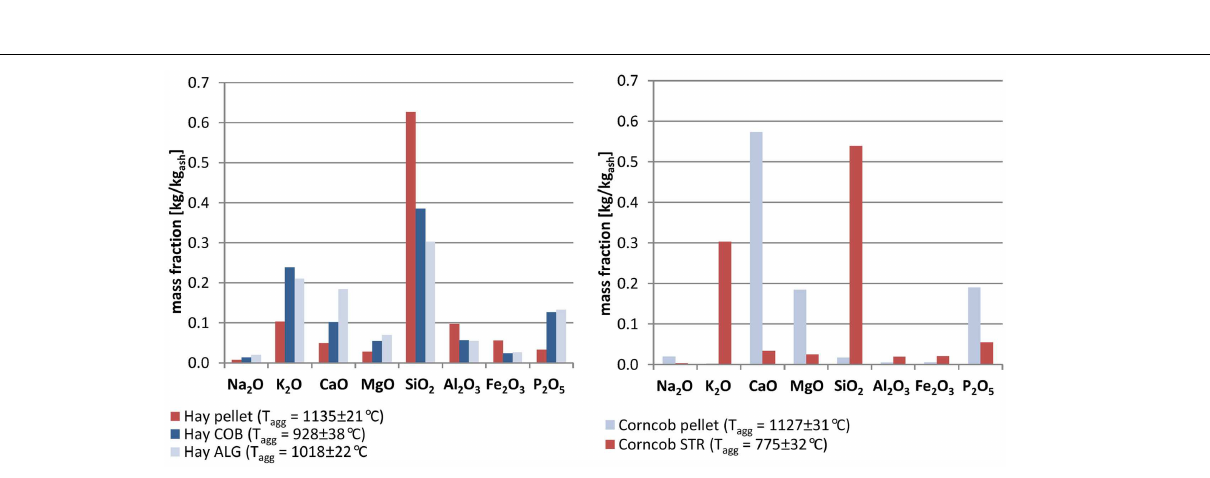
FIGURE 8 | Differences in ash composition within fuel species (left: hay; right: corn-cobs) and their effect on agglomeration temperatures .